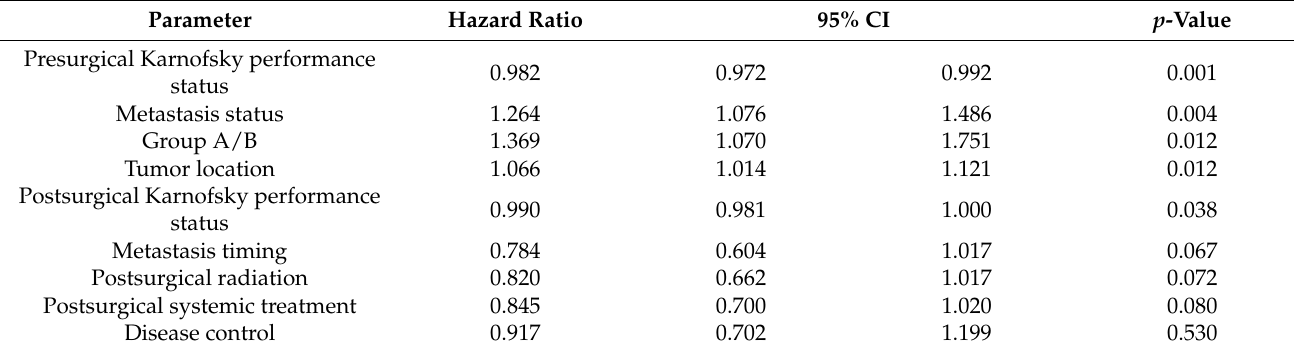
Table 3. Cox proportional hazards regression analysis shows age group, tumor location, metastasis status, pre- and postsurgical Karnofsky performance status (KPS) as independent prognostic factors for overall survival in the entire population.